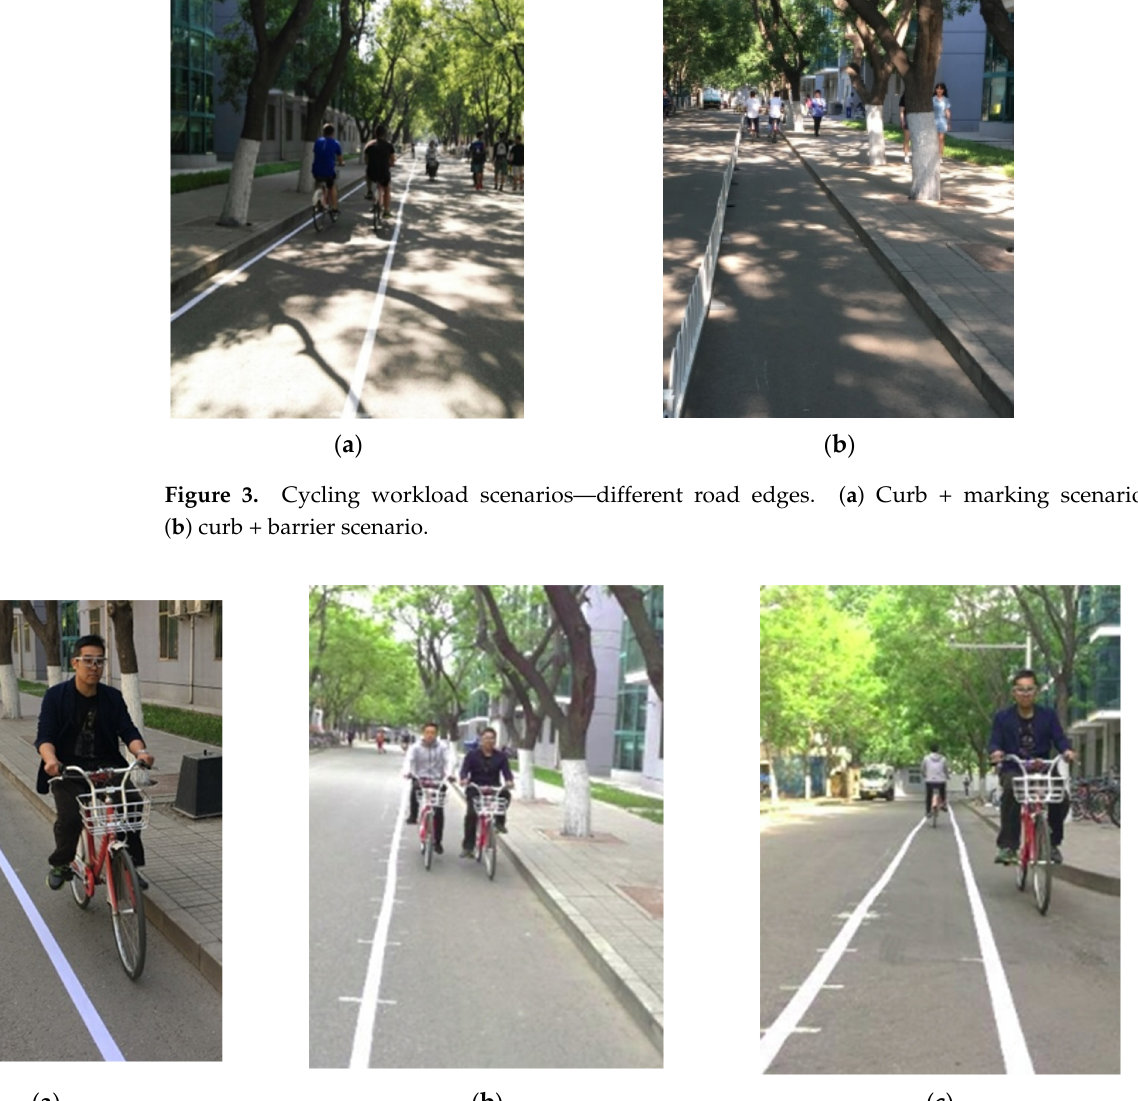
Figure 2. Cycling workload scenarios—different widths.